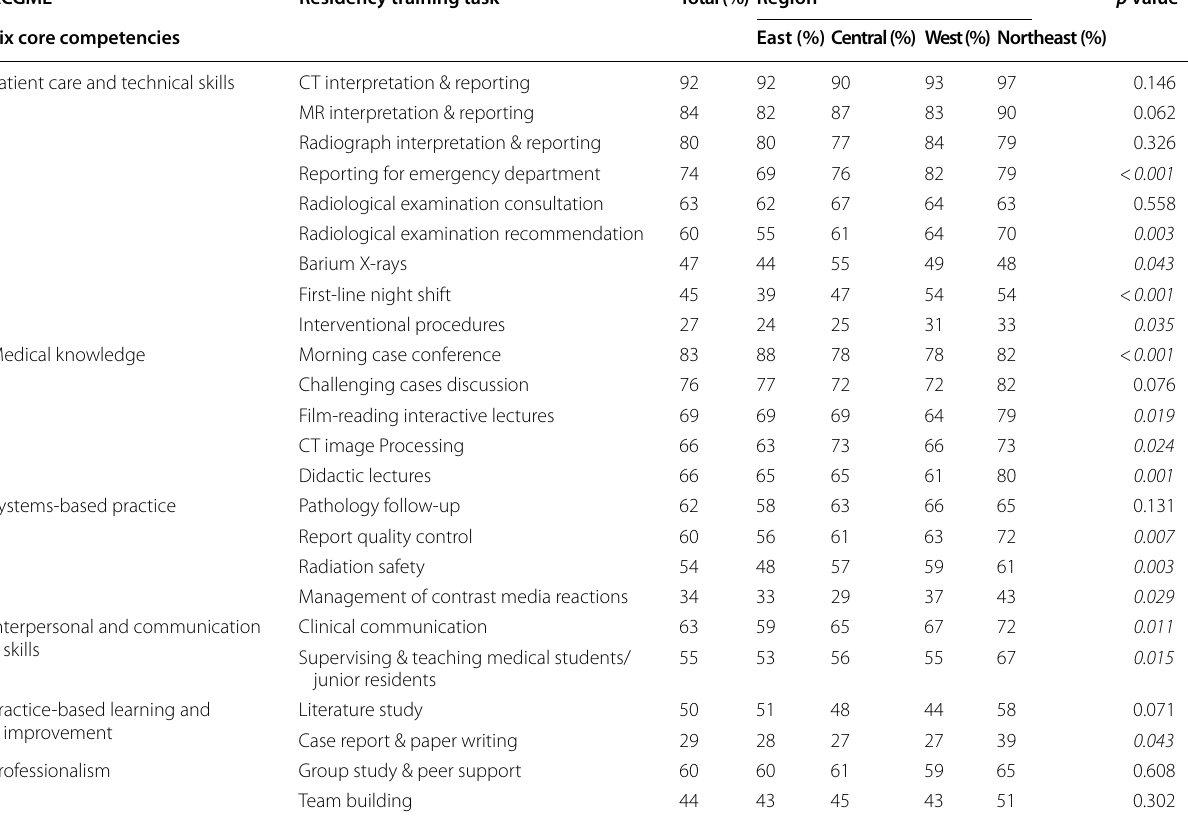
A task that was rated with a score of 4 or 5 was viewed as “very frequent.” p values were from Pearson’s Chi-square tests. The four regions were defined by China’s National Bureau of Statistics based on the geographic location and economic status. The eastern region contains 10 highly developed coastal provinces